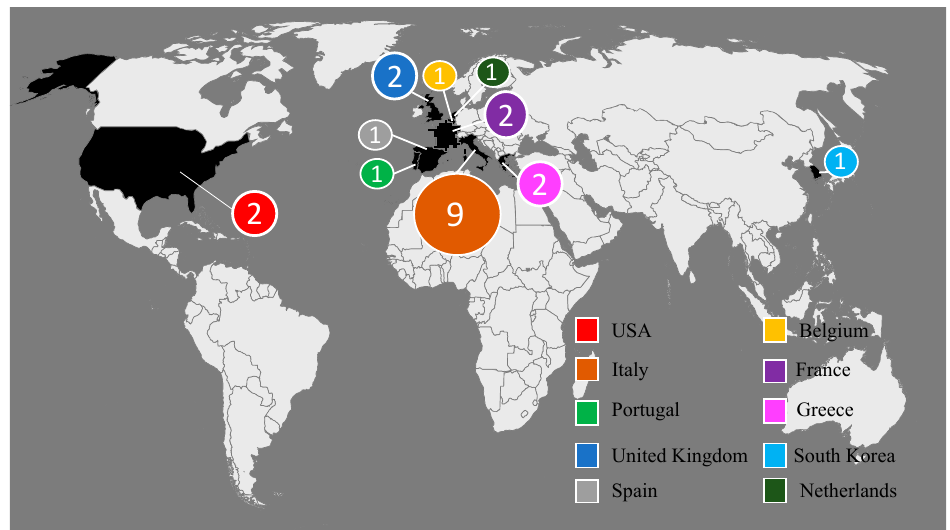
Figure 2. The number of articles per country reporting about E&HF in HRC.